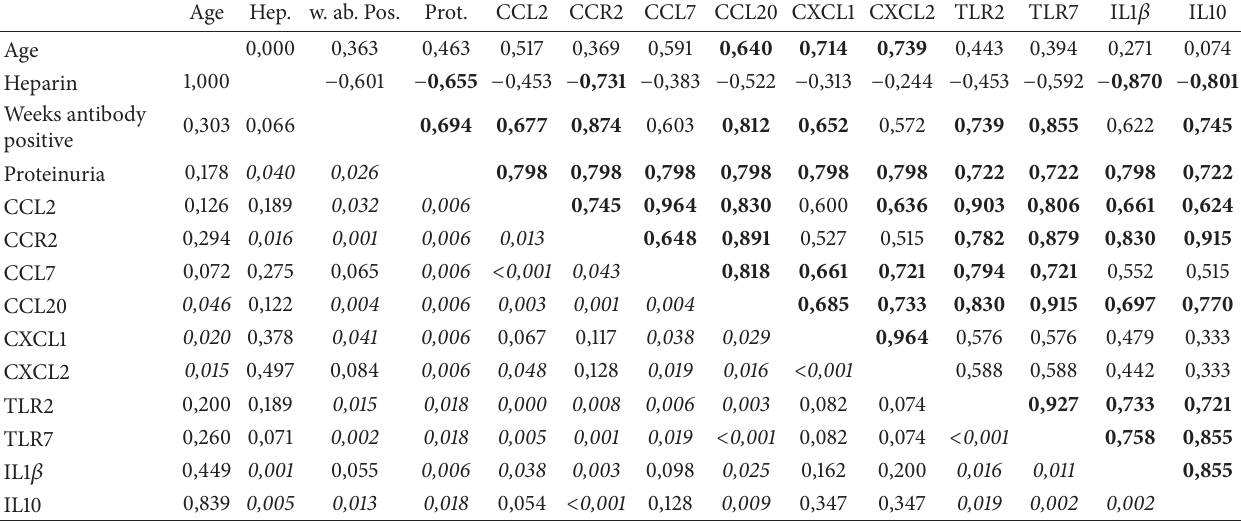
Table 1: Spearman correlation matrix performed on gene expression in heparin and nontreated age-matched B/W mice.